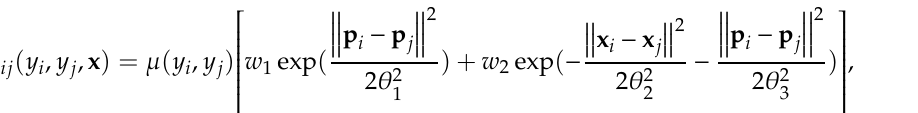
Figure 6. The Sigmoid function with scaling parameter λ and translation parameter